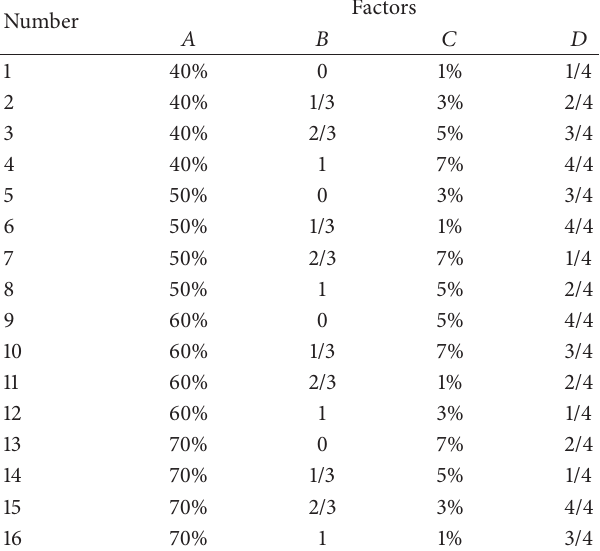
Table 2: The proportions of raw materials of each